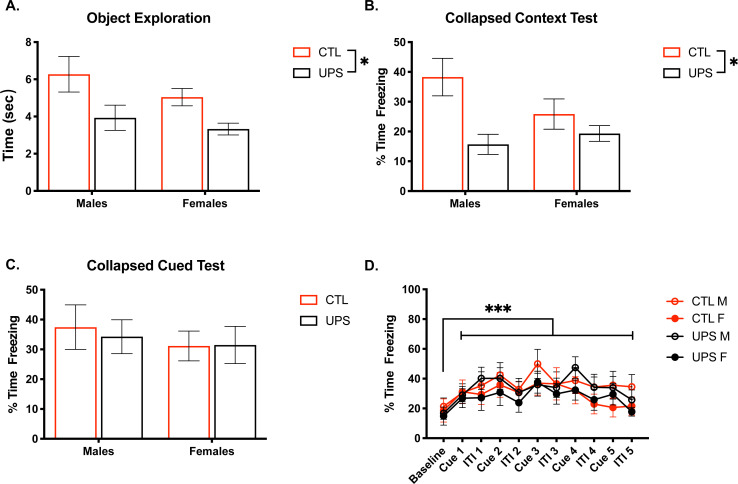
Behavioral testing in a third cohort of adult mice found consistent effects of rearing in the object exploration and contextual fear conditioning, but not acoustic-mediated fear learning.(A) Object exploration (rearing: F (1,50)=8.81, p=0.005, hp2 = 0.15; sex: F (1,50)=1.79, p=0.19, hp2 = 0.035; interaction: F (1,50)=0.21, p=0.65, hp2 = 0.055) (B) Contextual fear conditioning (rearing: F (1,48)=9.24, p=0.004, hp2 = 0.16; sex: F (1,48)=0.84, p=0.36, hp2 = 0.017; interaction: F (1,48)=2.81, p=0.10, hp2 = 0.004). (C) Acoustic-mediated fear conditioning (rearing: F (1,47)=0.051, p=0.82, hp2 = 0.001; sex: F (1,47)=0.51, p=0.48, hp2 = 0.011; interaction: F (1,47)=0.076, p=0.78, hp2 = 0.002). N = 13–15 per rearing and sex condition.